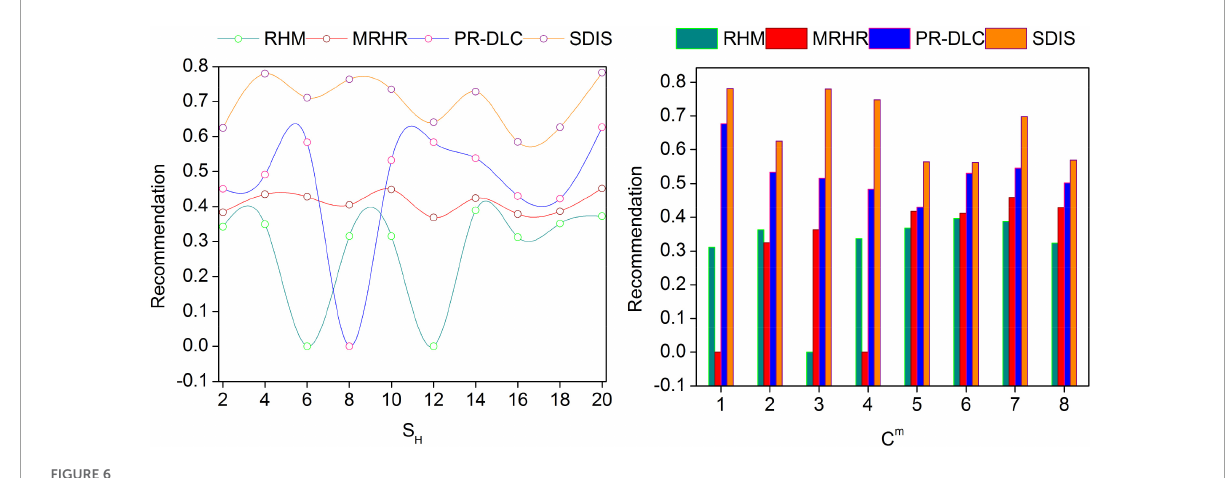
FIGURE6 Recommendation comparisons.